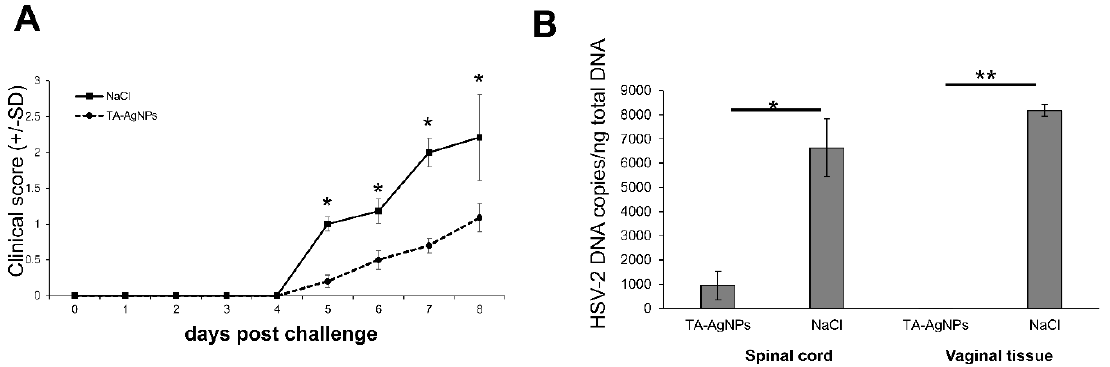
Figure 3. Tannic acid modified silver nanoparticles (TA-AgNPs) reduce genital HSV-2-infection in mice. C57BL6 mice were inoculated intravaginally with 10 3 PFU of HSV-2, then treated with 5 µg/mouse of TA-AgNPs at 6, 24, and 48 h after infection. Disease development expressed as mean disease score ( A ); (n = 5–20). ( B ) The numbers of the HSV-2 DNA copies in the vaginal tissues obtained on day eight post-infection, and in the spinal cord obtained on day eight of infection were assessed by PCR. The means are expressed as mean ± standard error of the mean (SEM) for n = 20; * represents significant differences with p ≤ 0.05, while ** means p ≤ 0.01.